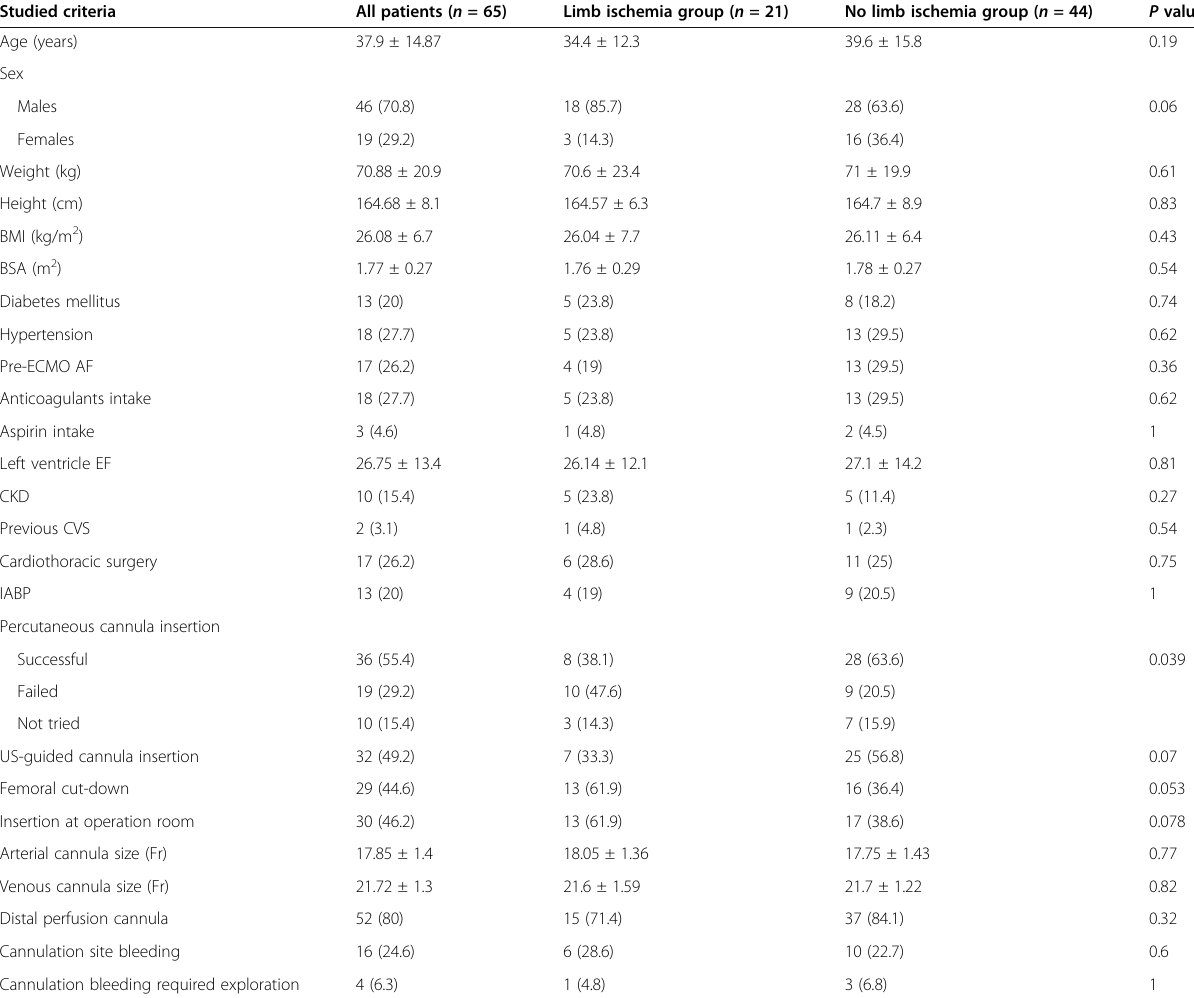
Table 1 Baseline clinical variables of the VA-ECMO-supported patients Studied criteria All patients ( n = 65) Limb ischemia group ( n = 21)